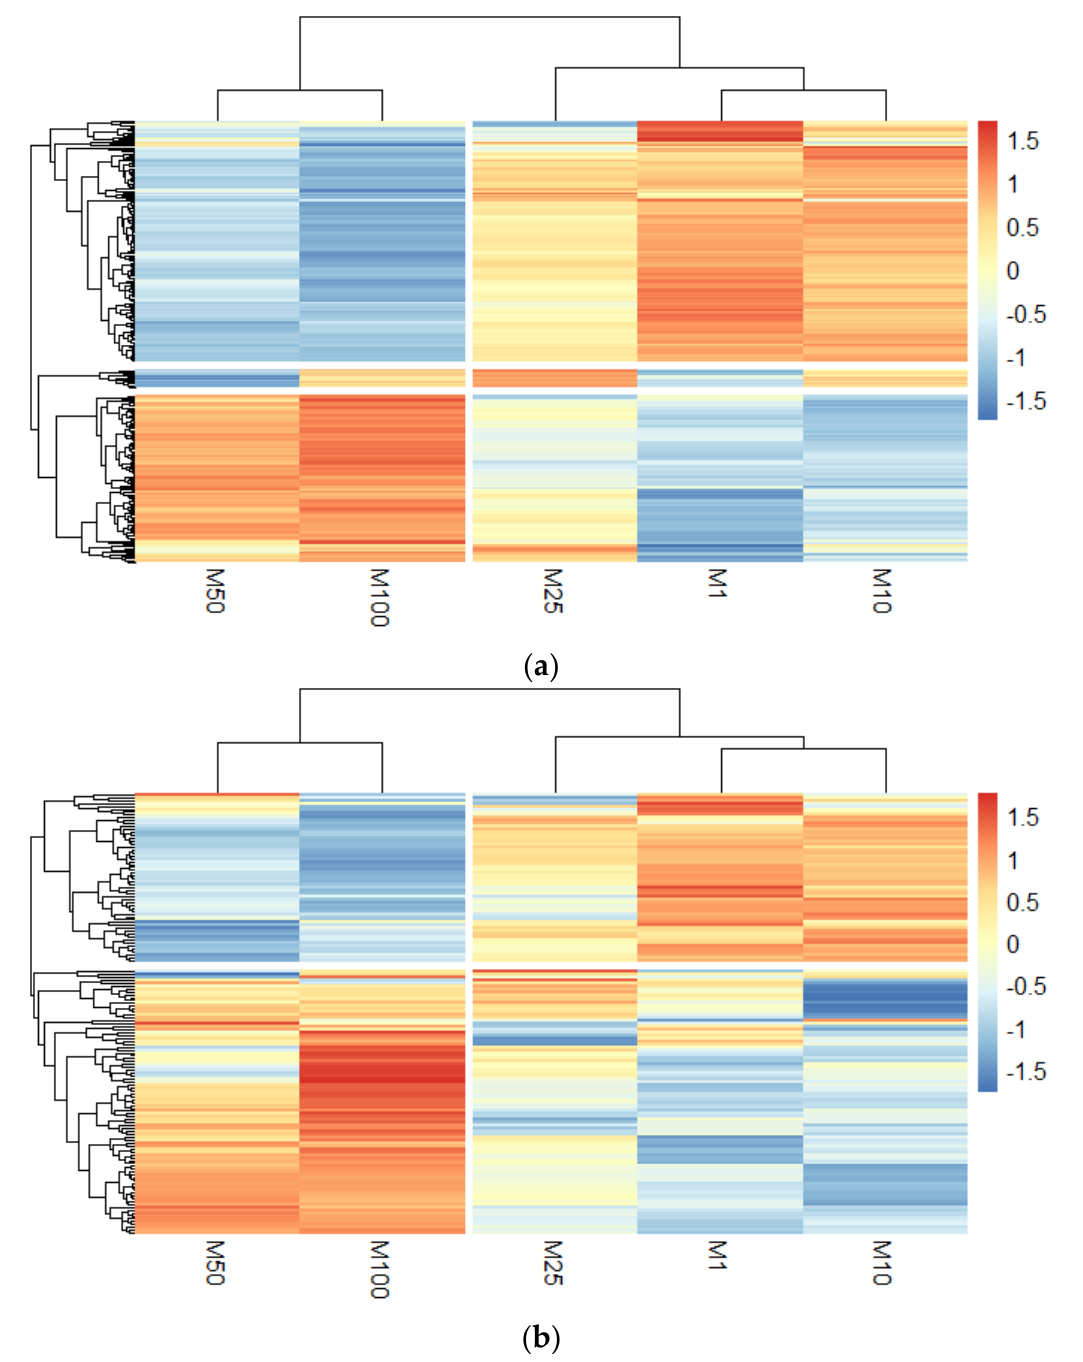
Figure 3. Heatmaps. ( a ) Heatmap of differentally expressed proteins (DEPs) for each morphine treatment (1, 10, 25, 50 and 100 μM) in human brain endothelial cells and ( b ) in extracellular vesicles. Rows are clustered using euclidean distance and the clustering method used is complete. K-means clustering is set at 2.